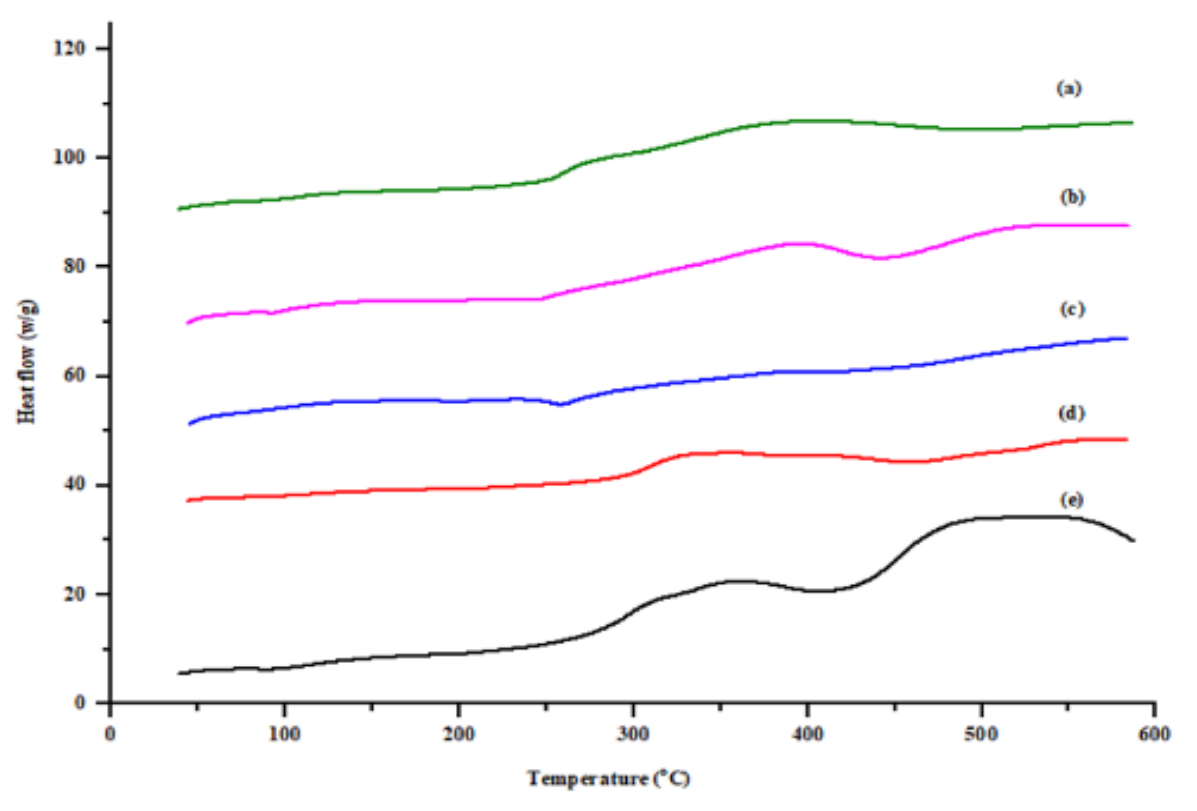
Figure 3. DSC thermogram of (a) spray-dried rifampicin (b) F4, (c) F5, (d) F6 and (e) F7.